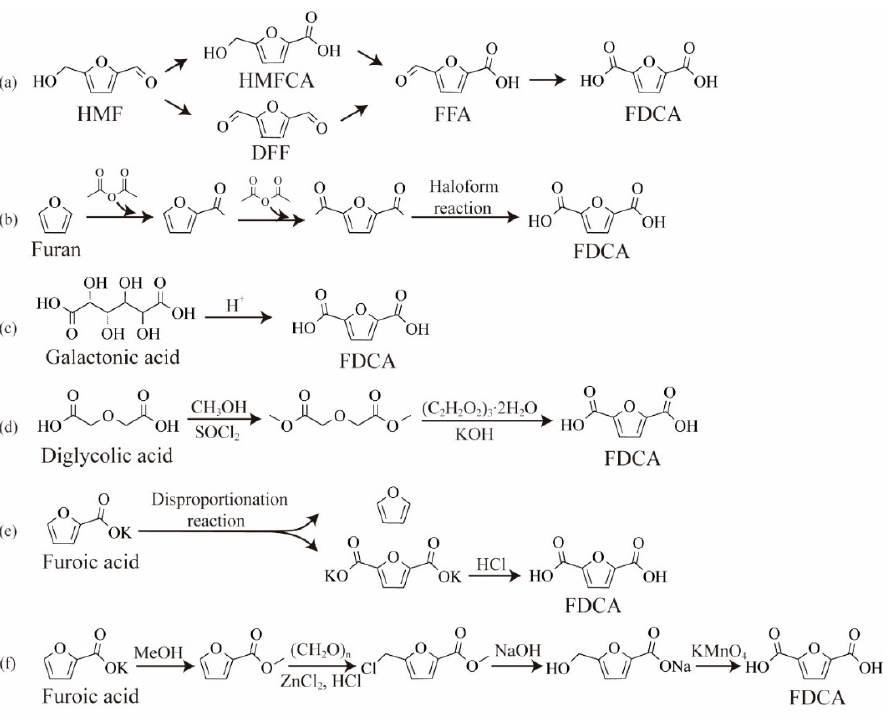
Figure 2. Schematic illustration of FDCA production with different substrates. ( a ) Synthesis of FDCA from HMF via two potential routes; ( b ) production of FDCA from furan by haloform reaction; ( c ) conversion of galactonic acid to FDCA under acidic conditions; ( d ) preparation of FDCA via dimethyl diglycolate from diglycolic acid; ( e , f ) production of FDCA from furoic acid through different catalytic